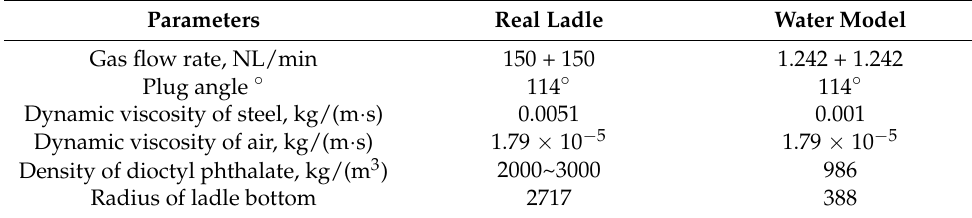
Table 1. Geometry parameters and material